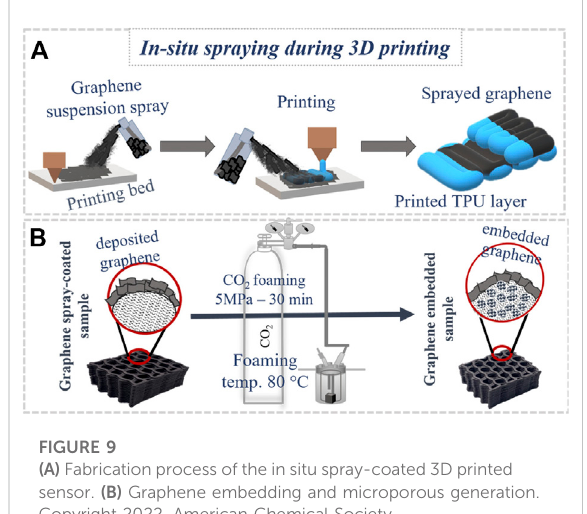
FIGURE 9 (A) Fabrication process of the in situ spray-coated 3D